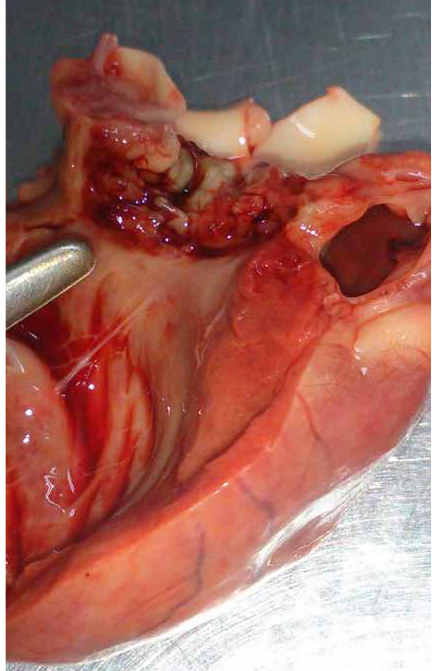
Figure 2: Heart necroscopic findings. Aortic valvular suppurative endocarditis with focal myocarditis. Note the large vegetation on valve